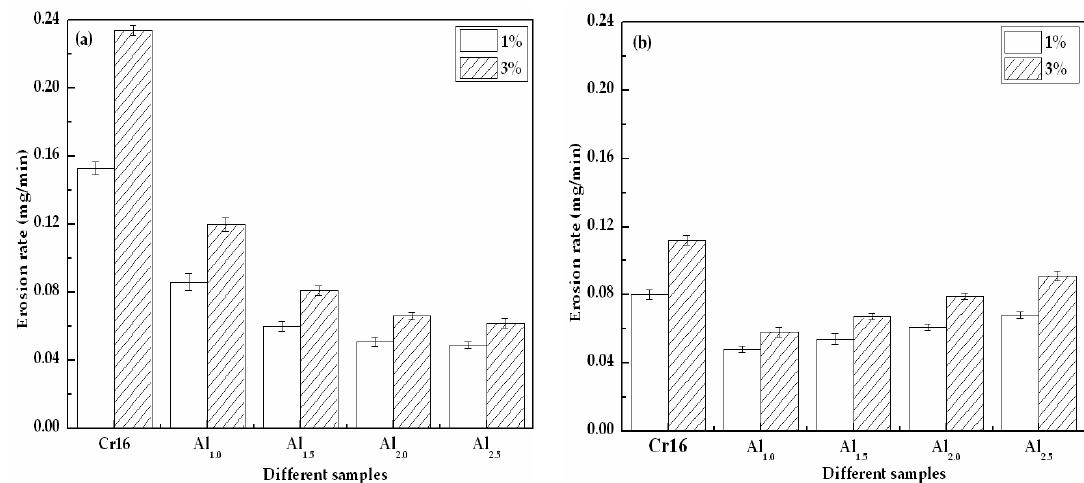
Figure 7. Variation in erosion rate of Al x CoCrFeNiTi 0.5 HEA coatings and Cr16 alloy with sand concentration at a velocity of 10.08 m/s and impingement angle of ( a ) 45° and ( b ) 90°.